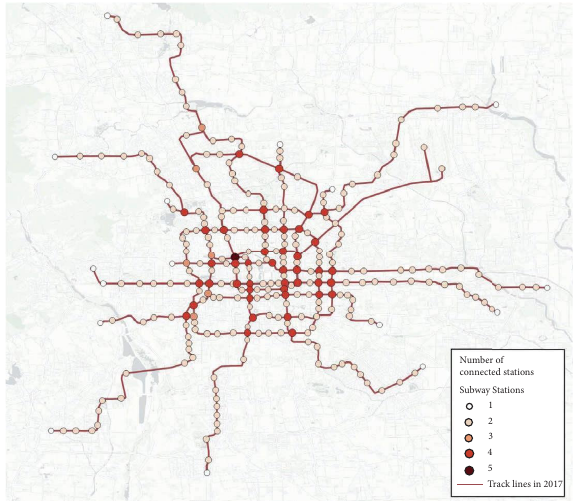
Figure 12: Te number of connected stations.